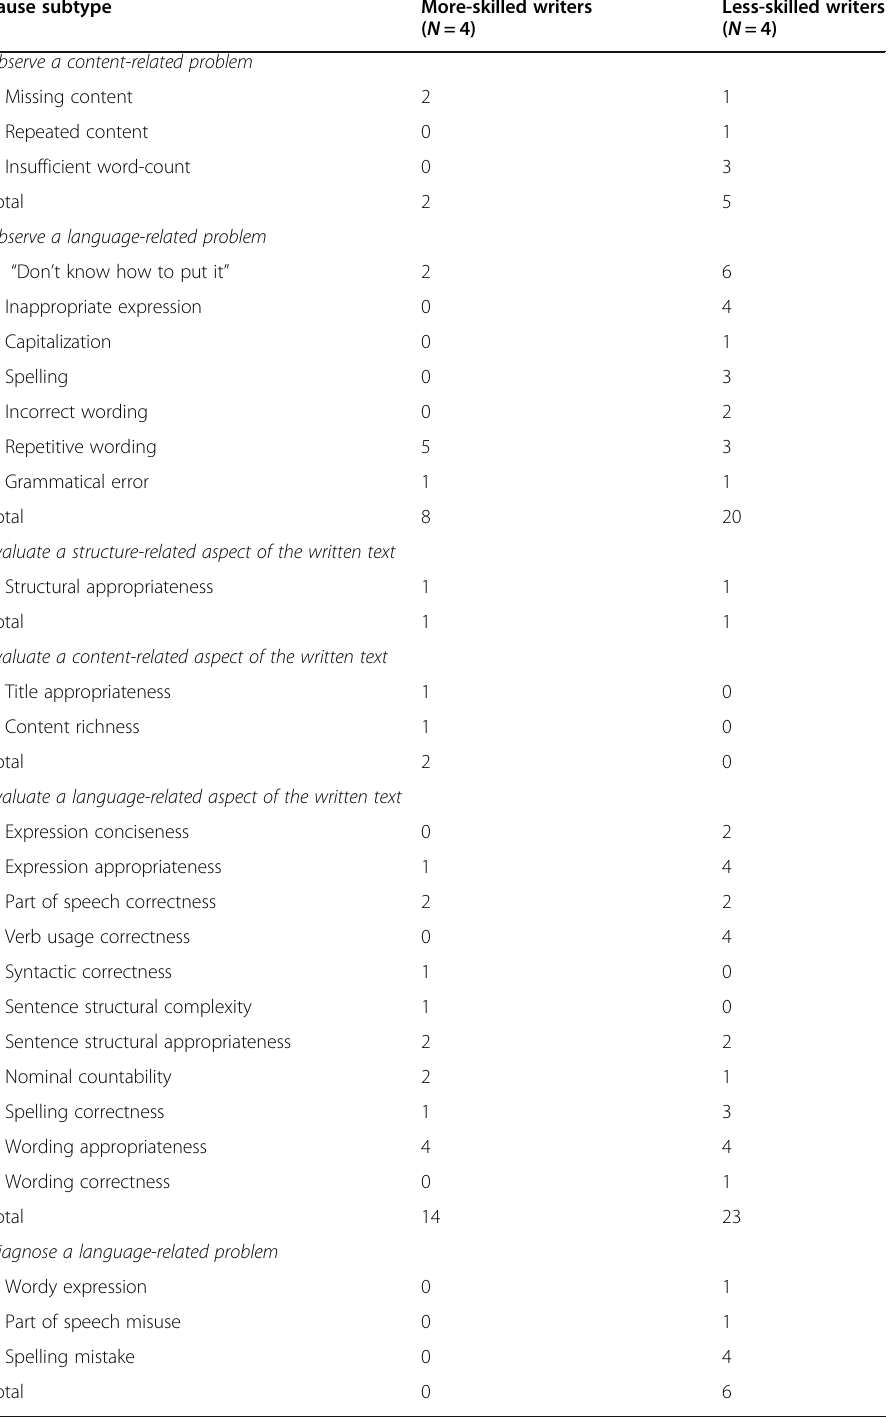
Table 7 Subtypes of pauses made by more- and less-skilled EFL writers Pause subtype More-skilled writers